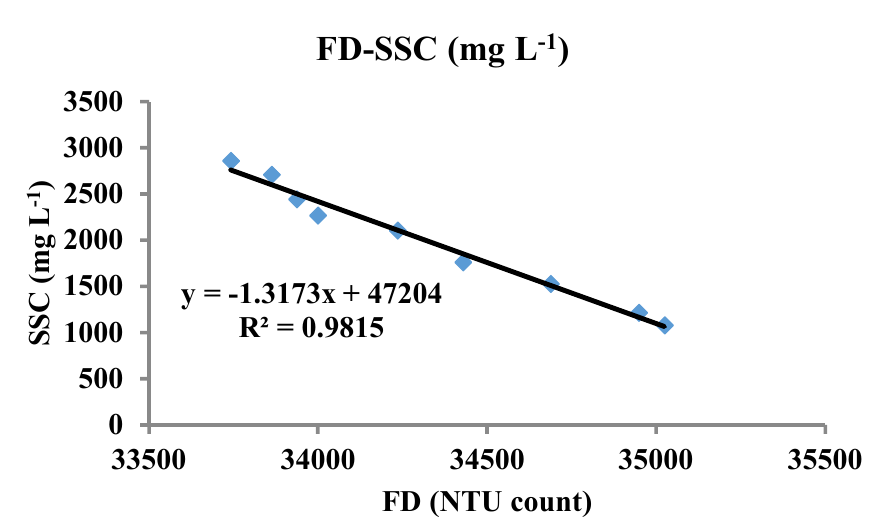
Figure A1. The relationship of FD Nephelometric Turbidity Unit (NTU) count with suspend sediment concentration for the OBS sensor used in tripod station T2.